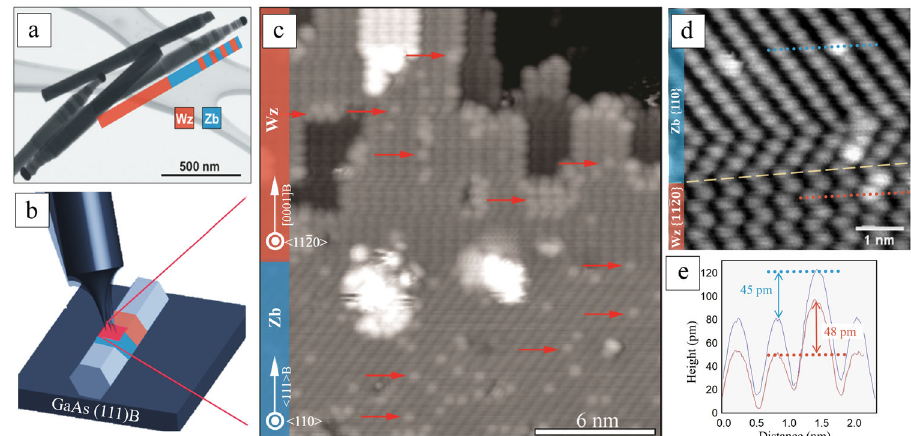
Fig. 1 NW sample preparation and NW surfaces. a Scanning electron microscopy image in transmission mode with crystal phase contrast of GaAs NWs, after transferring onto a suitable sample holder. Brighter and darker contrast corresponds to Zb and Wz, respectively, as con fi rmed previously by transmission electron microscopy. b Schematic description of the STM imaging setup showing the STM tip accessing a NW side facet. Orange (blue) color indicates Wz (Zb) segment. The red square demonstrates the area being scanned by STM. c Atomic-scale STM image of a Bi-exposed GaAs NW with a Wz f 11 (cid:1) 20 g - (top) and Zb {110}- (bottom) type facet, with some Bi atom sites marked by red arrows. Monolayer-high surface steps are found on the f 11 (cid:1) 20 g - facet, resulting in terraces of four different heights. Two small bright patches of remaining oxide or adsorbates can be seen close to the Wz – Zb interface. d A zoom-in fi lled state STM image of the Wz/Zb interface, showing the group-V atoms. The yellow dashed line indicates the interface between Wz f 11 (cid:1) 20 g - (bottom) and Zb {110}- (top) type facet. The brighter dot-like protrusions are Bi incorporation sites, which match well with the As lattice sites. The gray scale range, i.e., the brightest pixel to darkest pixel for ( c ) is 670 pm, and for (d) is 104 pm. (e) Line scan along the blue (orange) line in (d) showing the height of the protruded atom in Zb (Wz) segment. STM images were obtained at ( c ) V T = − 3.5 V, I T = 100 pA and ( d ) V T = − 4.4 V, I T = 75